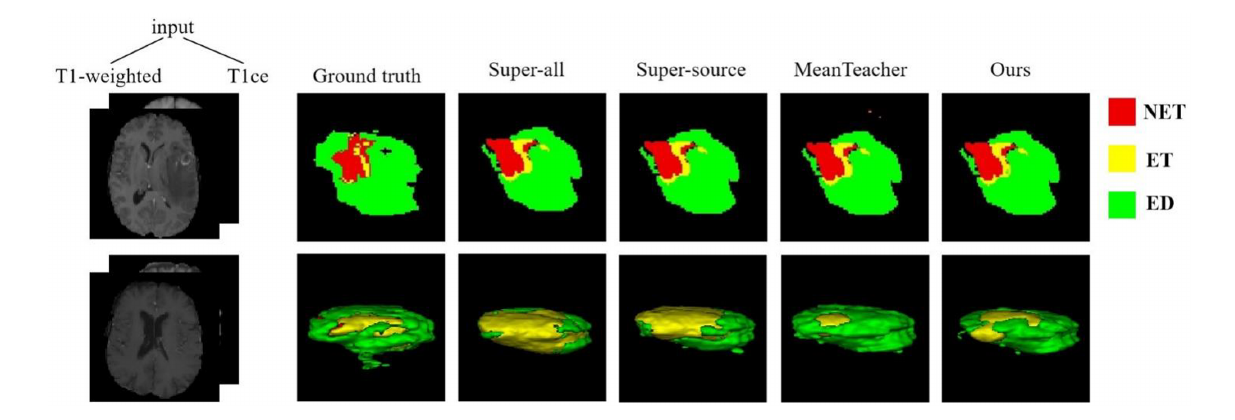
FIGURE 4 Examples of 2D slice and 3D segmentation results of different methods for T1-weighted and T1ce MR images in the T2 + FLAIR to T1 + T1ce UDA task. NET, non-enhancing tumor; ET, enhancing tumor; ED, peritumoral edema; T1ce, contrast-enhanced T1 images; FLAIR, fluid attenuated inversion recovery; UDA, unsupervised domain adaptation.